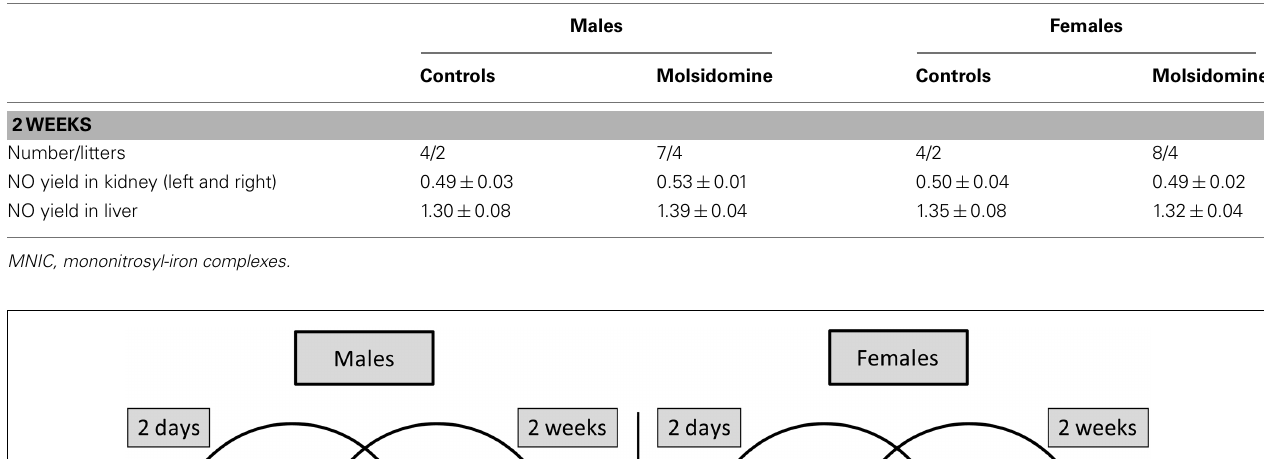
Table 2 | Nitric oxide yields (pmol MNIC/mg tissue) determined by EPR in kidneys and liver in of 2-week-old control FHH and 2-week-old FHH offspring of dams treated with molsidomine.